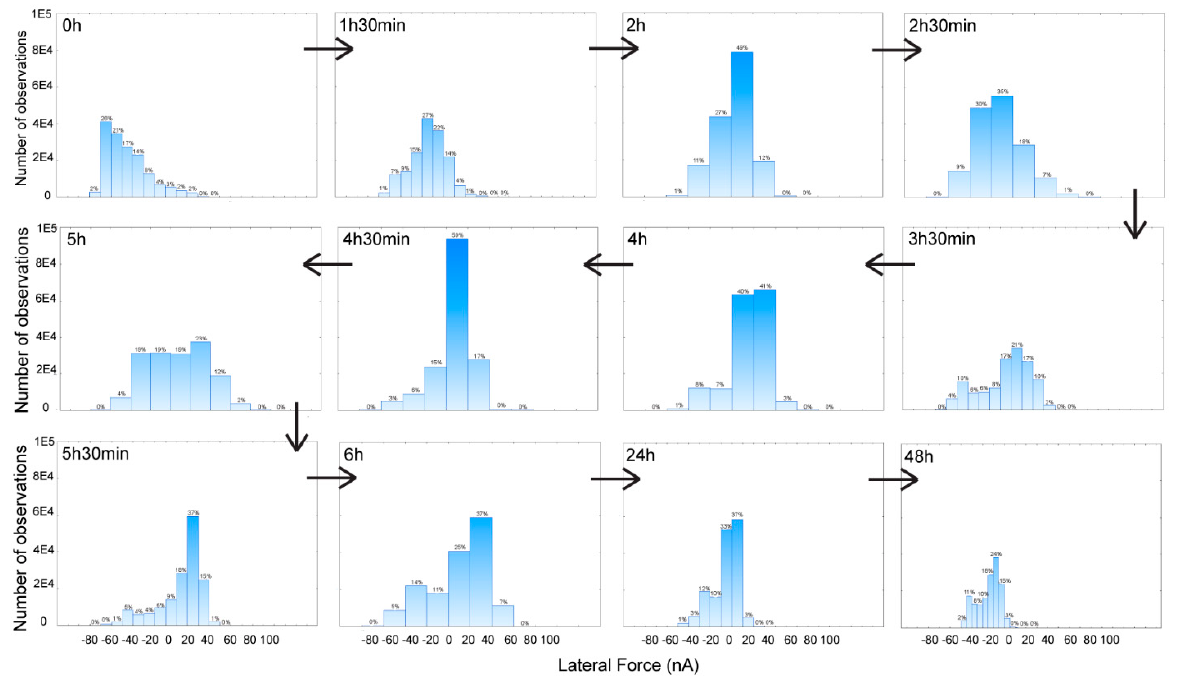
Figure 6. Sequence of histograms of the lateral force readings at various stages of hydrophobic recovery.